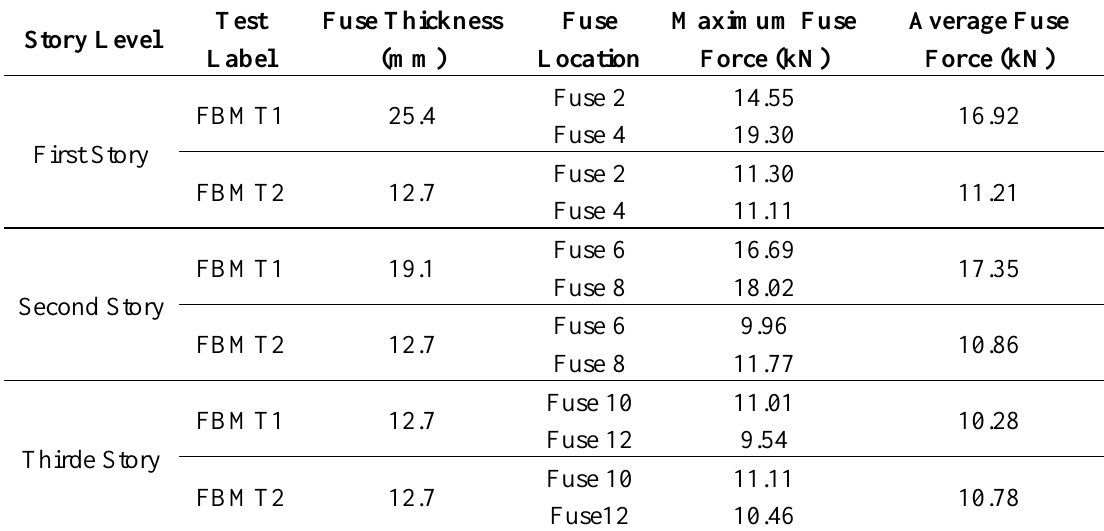
Table 5. Full brace monotonic test (FBMT) fuse